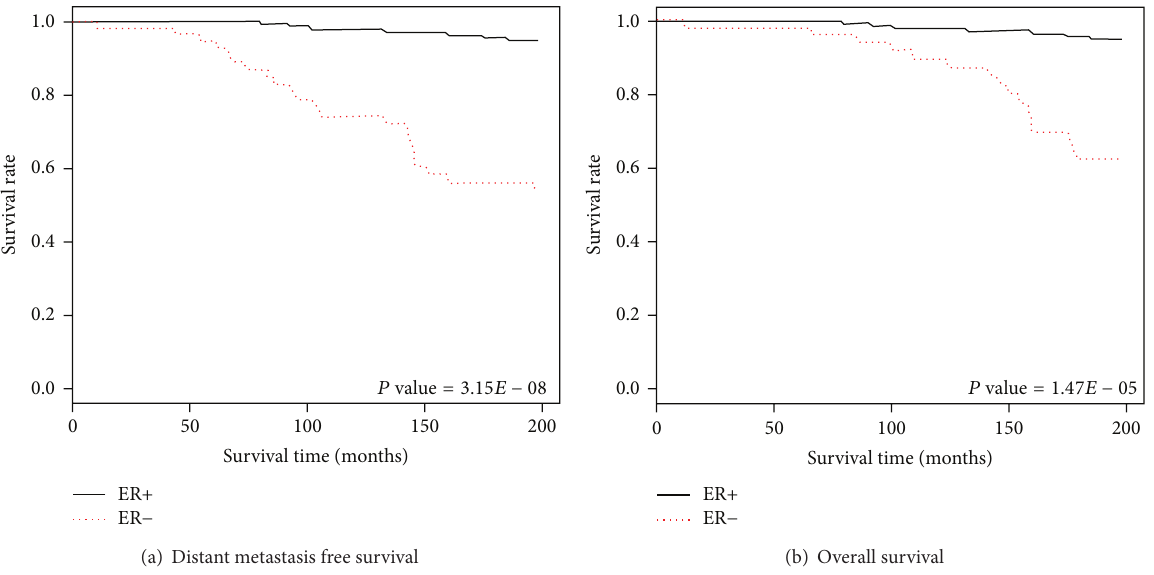
Figure 4: Kaplan-Meier survival graphs for ER+ and ER − patient groups in the Desmedt dataset, using the RRHGE gene signature (similar results achieved for van de Vijver dataset (data not shown)). A log-rank test was performed to evaluate the 𝑃 value, which signifies that the lower the 𝑃 value is, the better the separation between the two prognosis groups is. (a) Incorporating the DMFS rate to distinguish between ER+ or good prognosis groups (lower risk of distant metastasis) and ER − or poor prognosis groups (higher risk of distant metastasis). (b) Incorporating the OS rate that distinguishes ER+ or good prognosis groups (lower risk of death) and ER − or poor prognosis groups (higher risk of death). Both survival analysis graphs show good separation between the two prognosis groups, respectively.